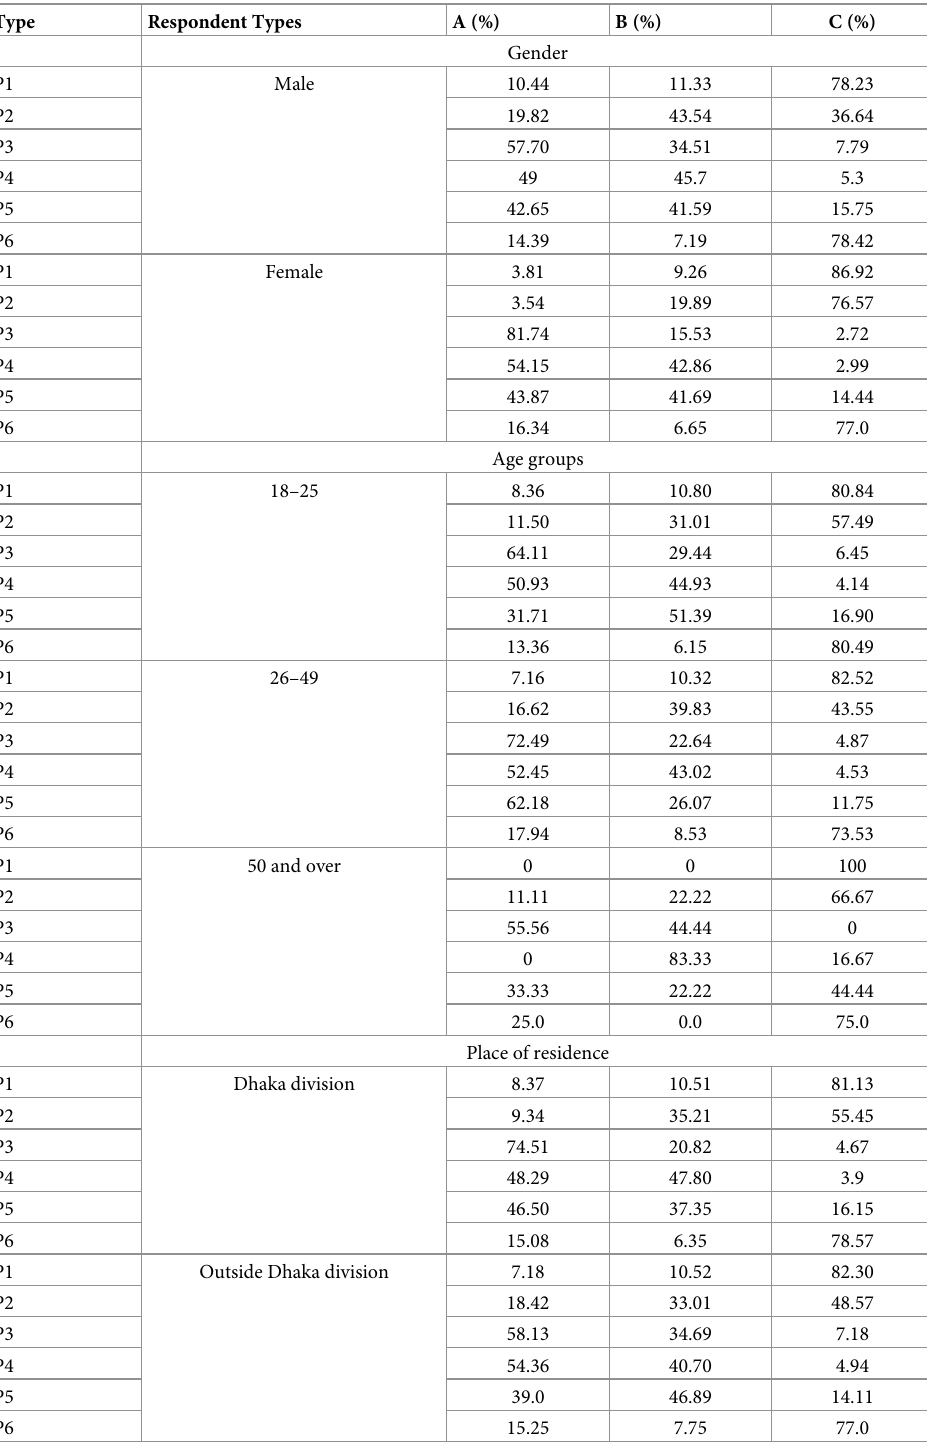
Table 5. Distribution of practice related characteristics among the